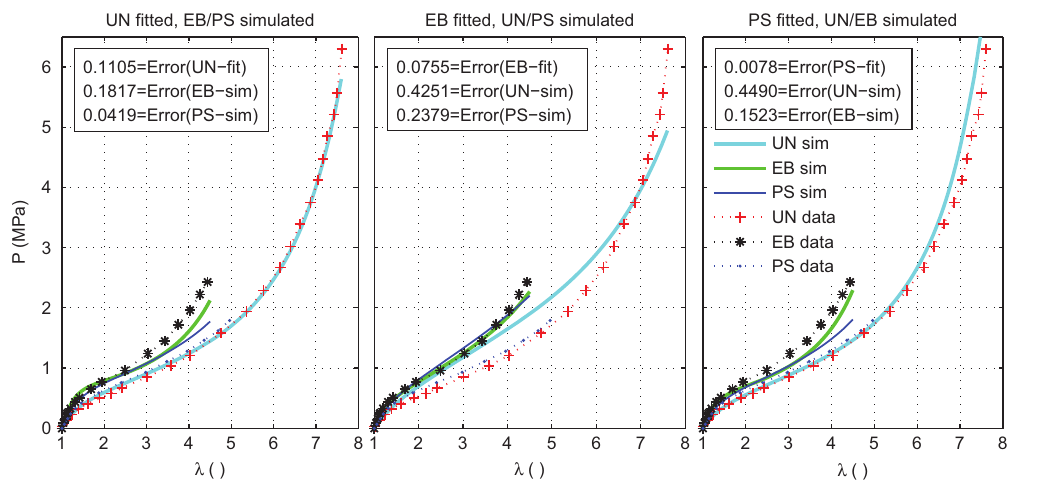
Figure 5 illustrates the corresponding fits together with the simulations of the other deformation modes that were not used during parameter identification. Addition- ally, the errors, in comparison with Treloar ’ s data, are summarized in the corresponding figures. The results show that the three-parameter Hart-Smith model gives a better fit than the two parameter Mooney-Rivlin model, and the reason for such improvement is not only because of an additional parameter but also the presence of the logarithmic term in the energy function. Moreover, the presence of such logarithmic term helps to capture the initial stiffness in the stress-stretch curve accurately (see also the performance of the Pucci-Saccomandi model in Section 4.2.5).